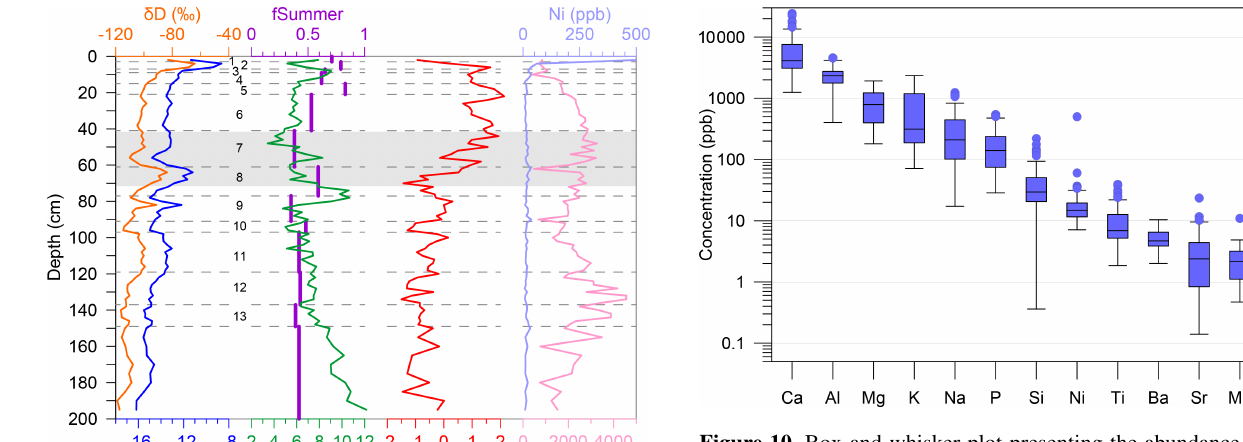
Figure 10. Box-and-whisker plot presenting the abundance of de- tectable elements in samples from the Skating Rink exposure, ar- ranged from most to least abundant. Central lines represent median values, boxes represent interquartile range, whiskers represent in- terquartile range × 1.5, and circles represent